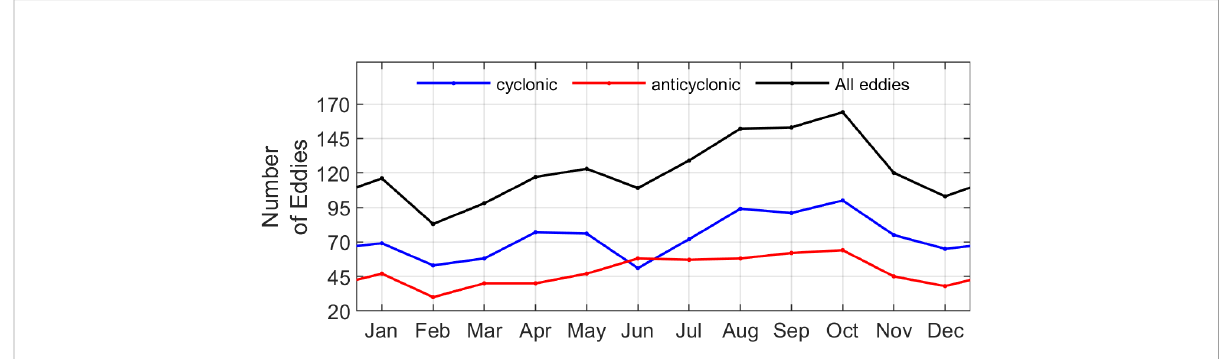
FIGURE 6 Seasonal cycle of the number of eddies generated off Northeast